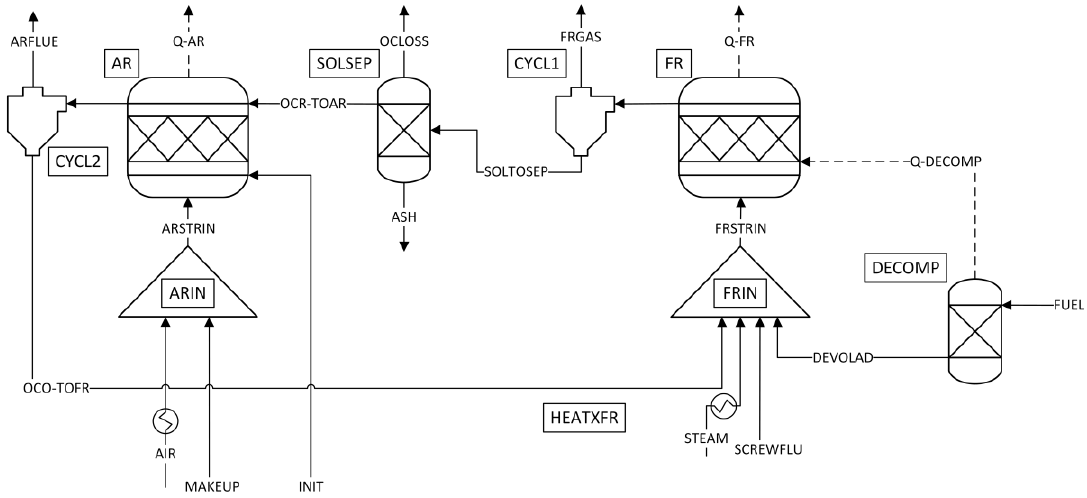
Figure 2. Flow sheet of the Aspen Plus ™ CLG process model.